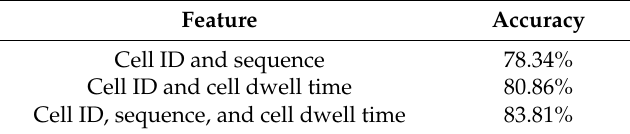
Table 6. The comparisons of the proposed method with different features for speed